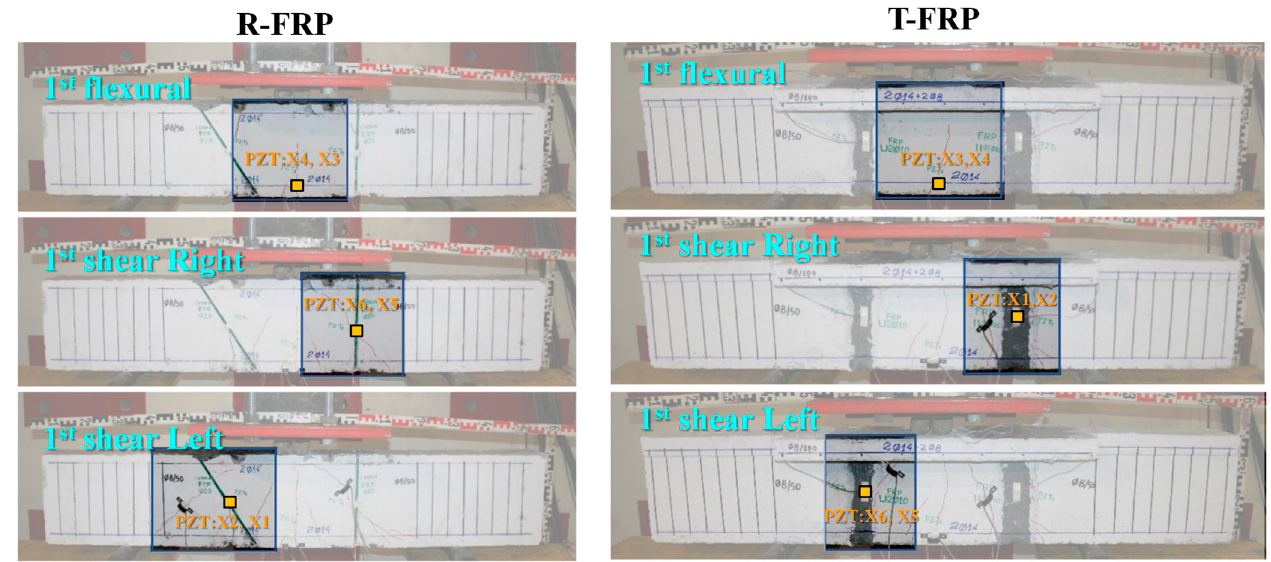
Figure 24. RMSD index values of externally bonded PTZs of T-FRP and R-FRP.